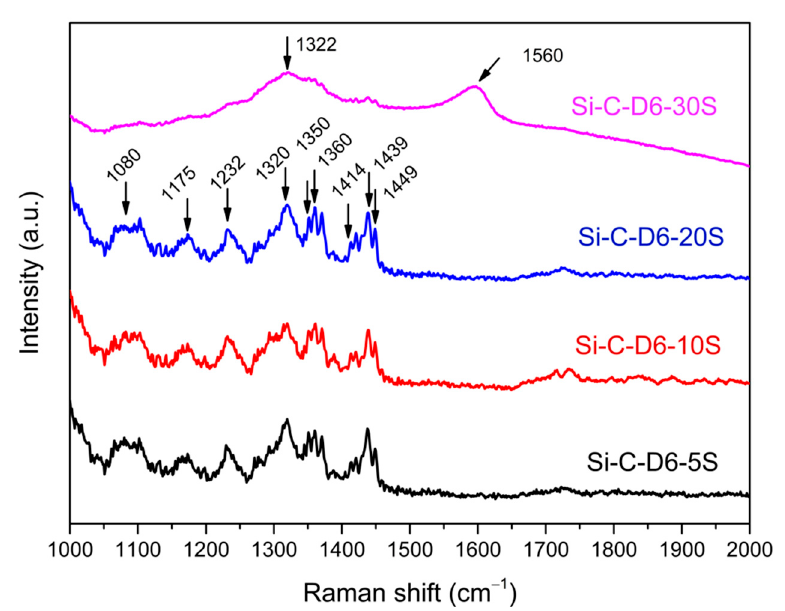
Figure 4. Raman spectra of the carbon deposited on Si substrates for various time and nozzle distances.